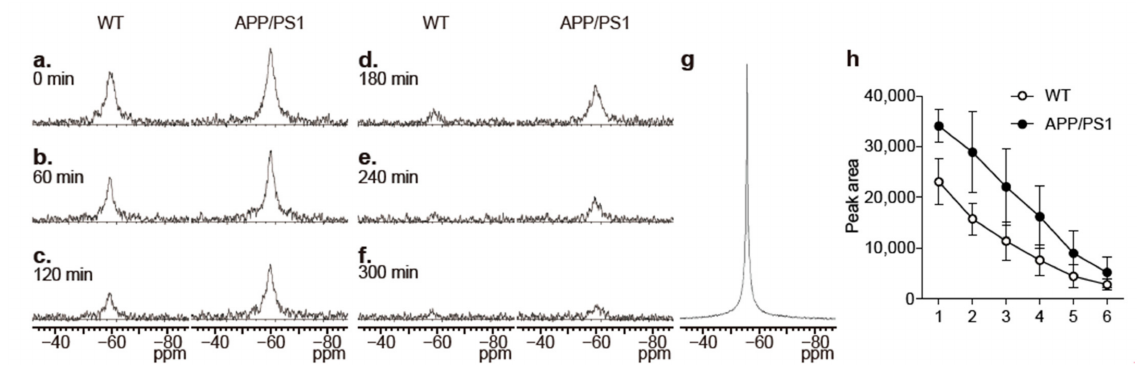
Figure 3. 19 F-NMR spectra from the mouse head. ( a – f ) Representative 19 F-NMR spectra from the mouse heads of wild-type (WT) and APP/PS1 mice that were obtained every 60 min from 30 min after the injection. The spectra in ( a ) to ( f ) were from the measurements 1 to 6 in Figure 2, respectively. ( g ) 19 F-NMR spectra of Shiga-Y51 dissolved in DMSO. Chemical shifts (ppm) were referenced to C 6 F 6 at − 163 ppm as an external standard. The FID signal was processed with 40 Hz line broadening similarly to CSI data. The line width of 19 F signal in the 19 F-NMR of Shiga-Y51 dissolved in DMSO was 177 Hz, whereas the 19 F-NMR spectra from the mouse head showed the line width of 760 Hz. ( h ) The time course of changes in the peak area was measured in WT ( n = 4) and APP/PS1 mice ( n = 3). Data are presented as mean ± standard error of mean